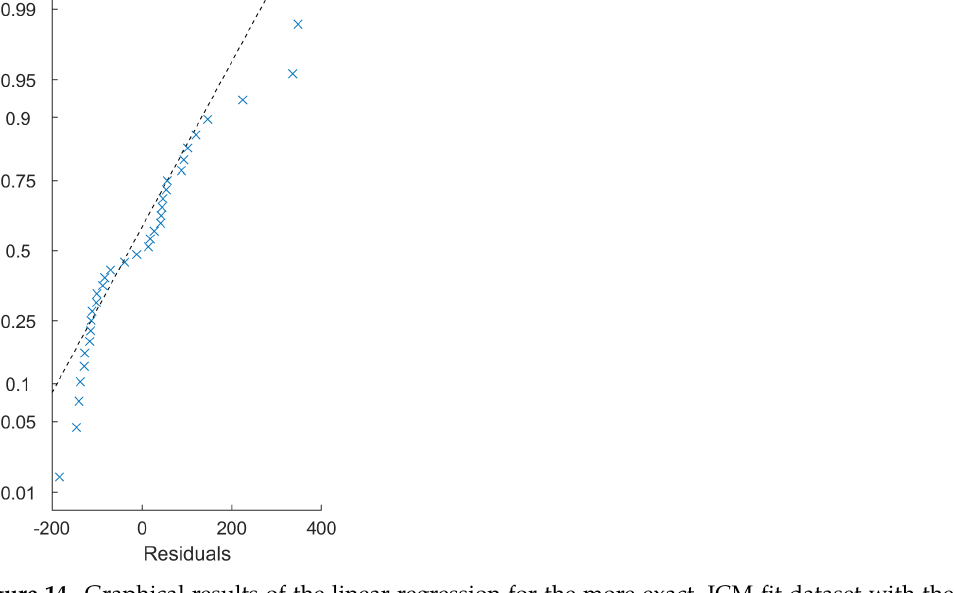
Figure 14. Graphical results of the linear regression for the more exact, ICM-fit dataset with the standard regression model: The data do not seem to align well with linear regression. Residuals seem to be non-normal. Removing hand-selected outliers based on overall image intensity did not improve the dataset considerably in this regard.